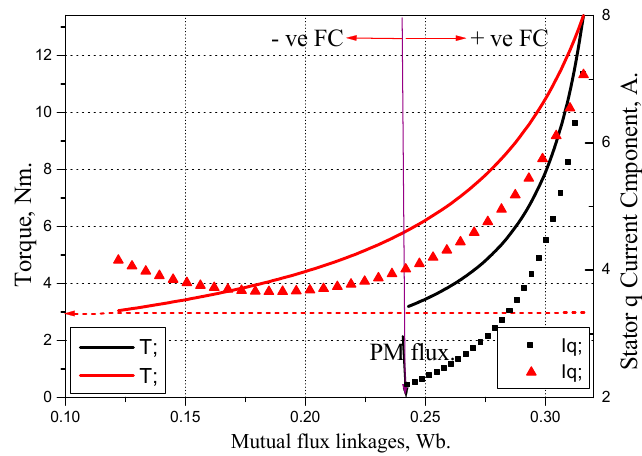
ff ected by stator mutual